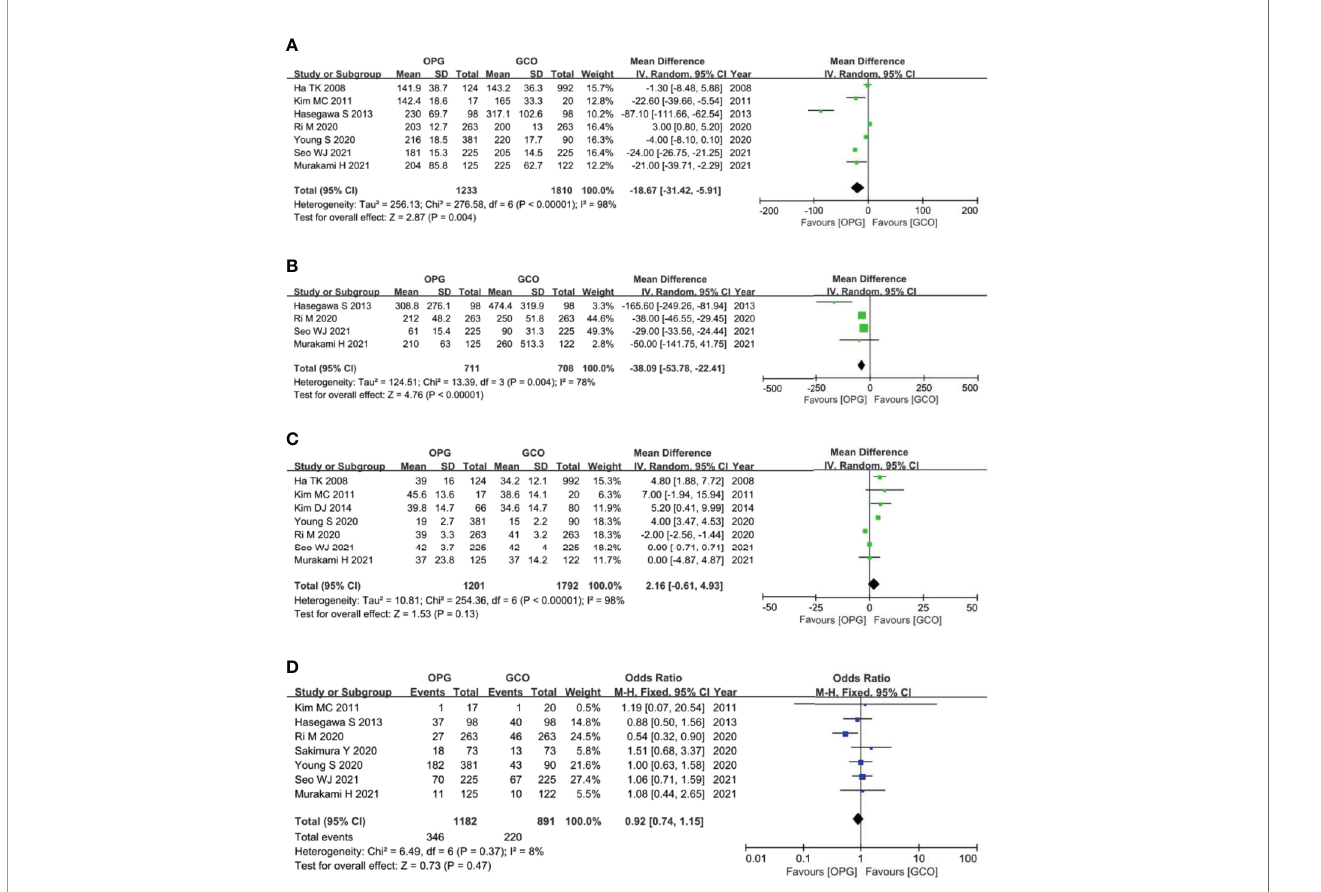
( Figure 5B ) recurrence rates of OPG and GCO